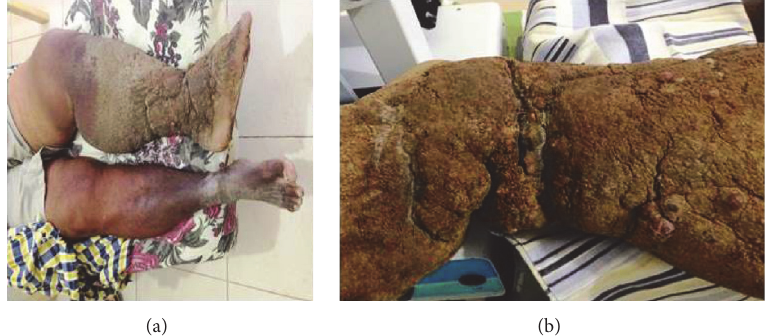
Figure 1: Skin plaque of severe lymphedema of the leg and foot with significant involvement of the ankle joint.